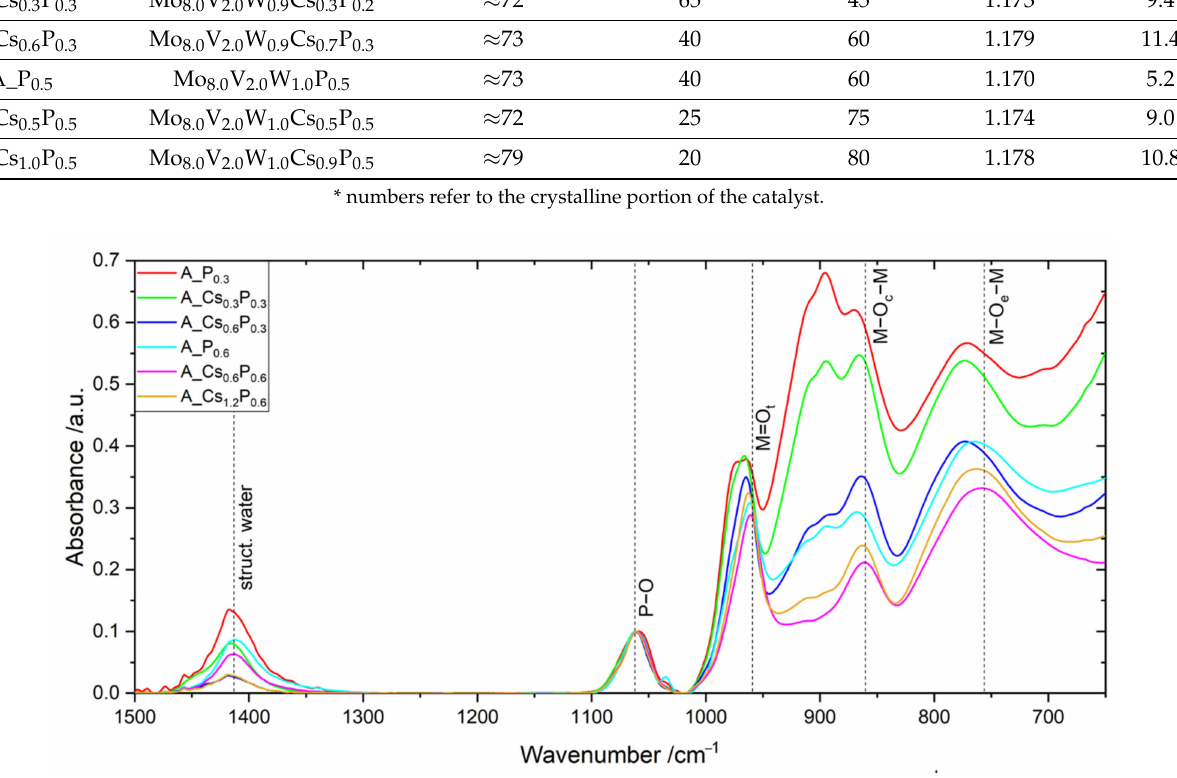
Figure 9. IR spectra of catalyst A prior to and after adding Cs and P with different Cs/P and (Mo + V + W)/P ratios. The IR spectra are normalized to the characteristic P-O band at 1062 cm − 1